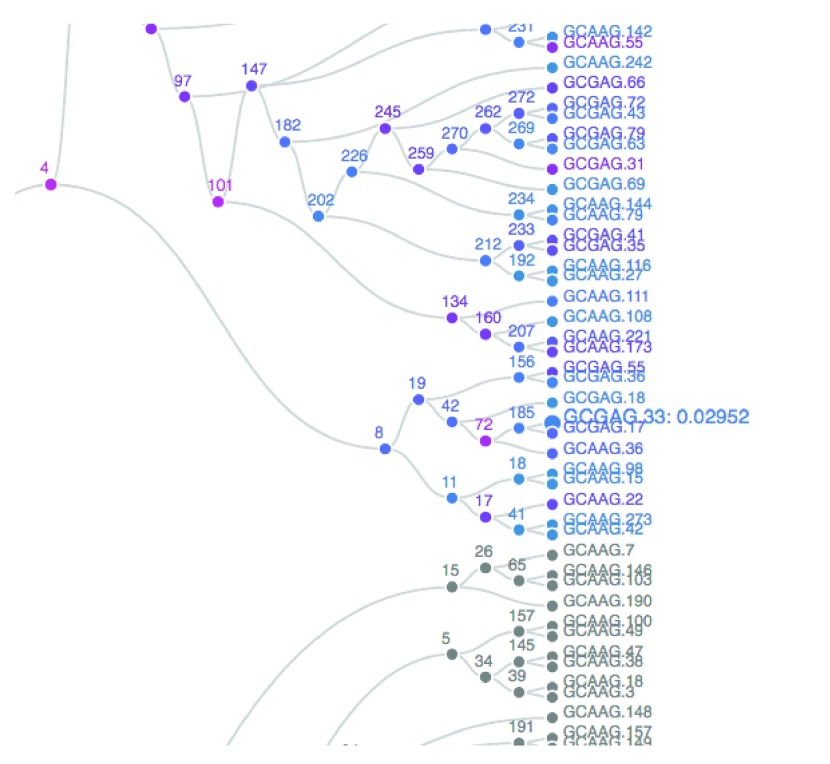
A screenshot of a subtree with many differentially abundant bacteria, as determined by the hierarchical testing procedure.Currently the user is hovering over the node associated with bacteria GCGAG.33; this causes the adjusted
p-value (0.0295) to appear.